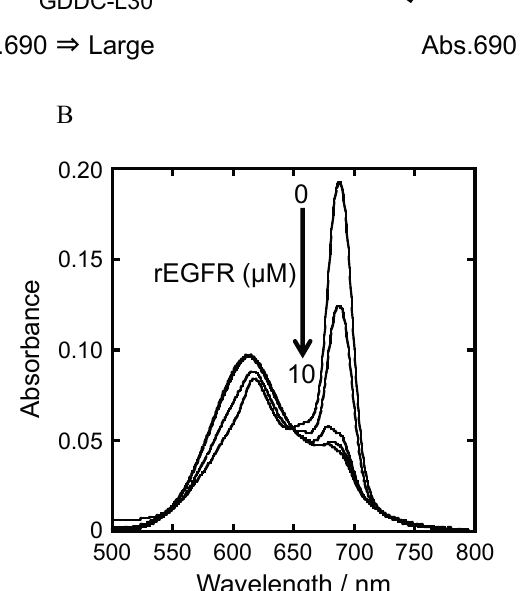
Figure 9. ( A ) Strategy to study the release of CuAPC from GDDC-L30 in response to rEGFR; ( B ) Visible absorbance spectra of 2.5 µM CuAPC/2.5 µM GDDC-L30 complex with 0–10 µM rEGFR. The sample was heated at 80 °C for 2 min, the gently cooled at 2 °C·min − 1 before